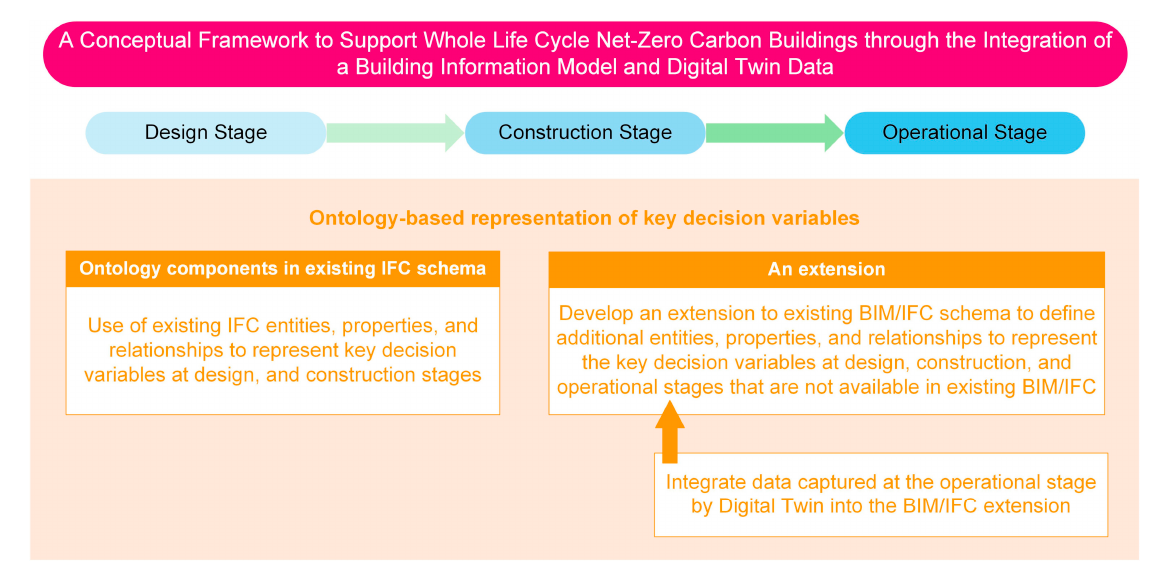
Figure 12. Conceptual framework to support whole-life-cycle net-zero-carbon buildings through the integration of a building information model and digital twin data.